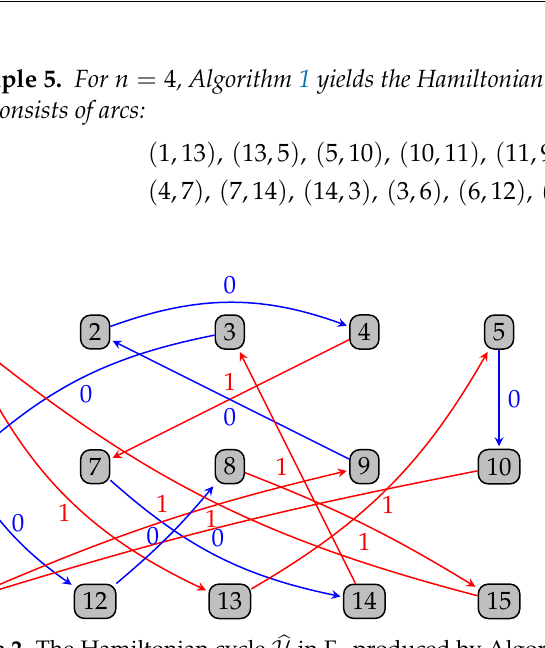
Figure 2. The Hamiltonian cycle (cid:98) H in Γ 4 produced by Algorithm 1 on v init = 1. It is generated by g ( x ) = x 10 + x 8 + x 5 + x + 1. The resulting sequence ( 0,0,0,1,1,1,1,0,1,1,0,0,1,0,1 ) has linear complexity 14, which is